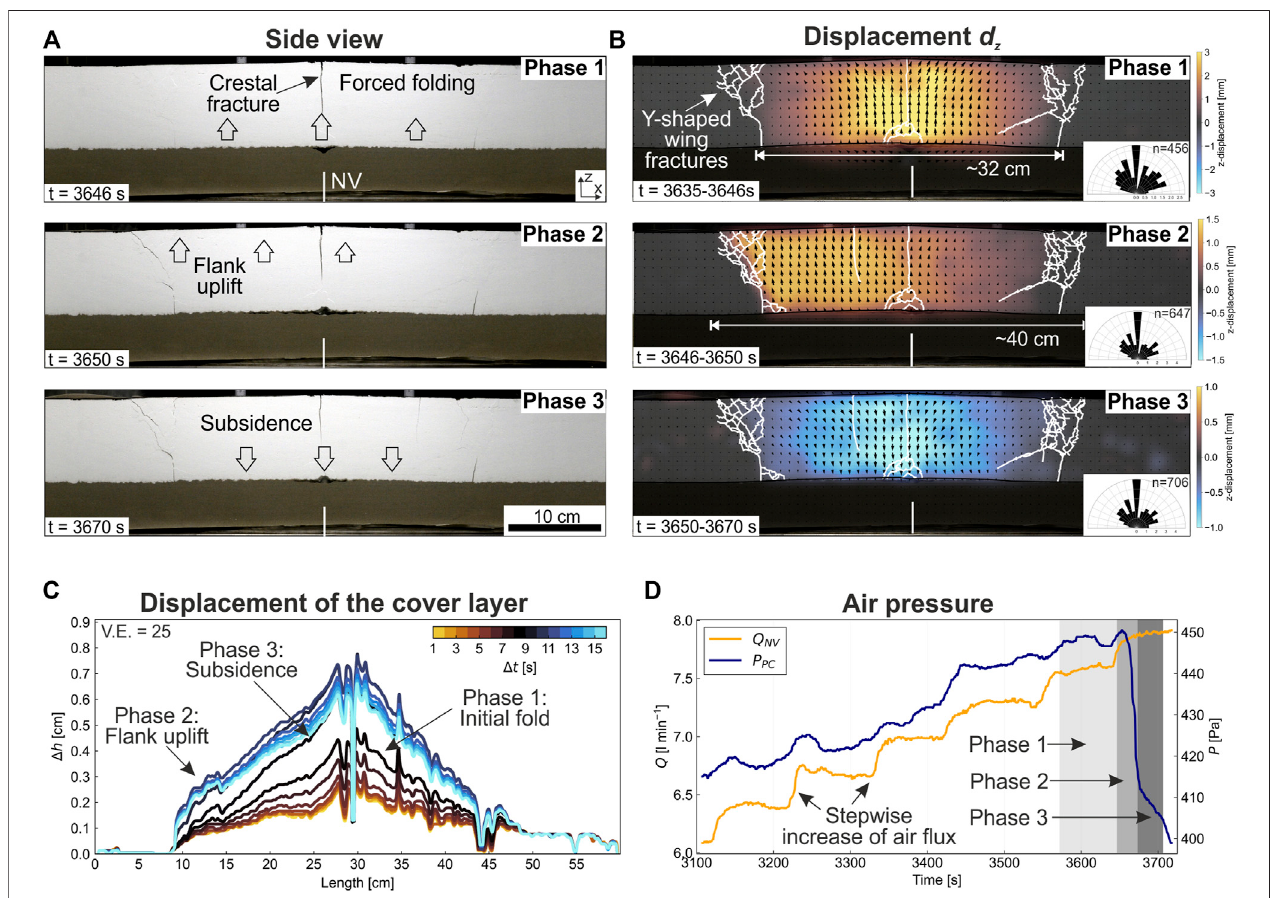
FIGURE 4 | Results of exp.1A, which consisted of a homogeneous cover layer and was performed in the 2D box con fi guration of the apparatus. (A) Side view photos showing the structural evolution. Phase 1: a central forced fold developed above the tip of the needle valve (NV). Phase 2: uplift of the left fl ank of the forced fold and breakthrough of the wing fractures. Phase 3: The central forced fold subsided. (B) Displacement vector fi eld derived from the DIC analysis. The background color representstheamountoftheverticaldisplacement d z (uplift=orangetobrown,subsidence=browntoblue).Eachimageshowsthecumulativedisplacementofthe speci fi ed time interval. The fracture segments (white lines) were interpreted from high-resolution photos ( see e.g. Figure 3 ). The rose diagrams show the dip directions normalized bythe length ofthe individual fracturesegments. (C) Time series of thesurface height (top ofthe whitelayer) plotted against thex-positionof theexperiment. (D) Time series of the air fl ux through the needle valve ( Q NV ) and the pressure in the pressure chamber ( P PC ). Air fl ux at the base of the pressure chamber ( Q PC ) was constant so that P PC was approx. 40% of the total vertical normal stress at the beginning of the experiment ( Table 1 ).